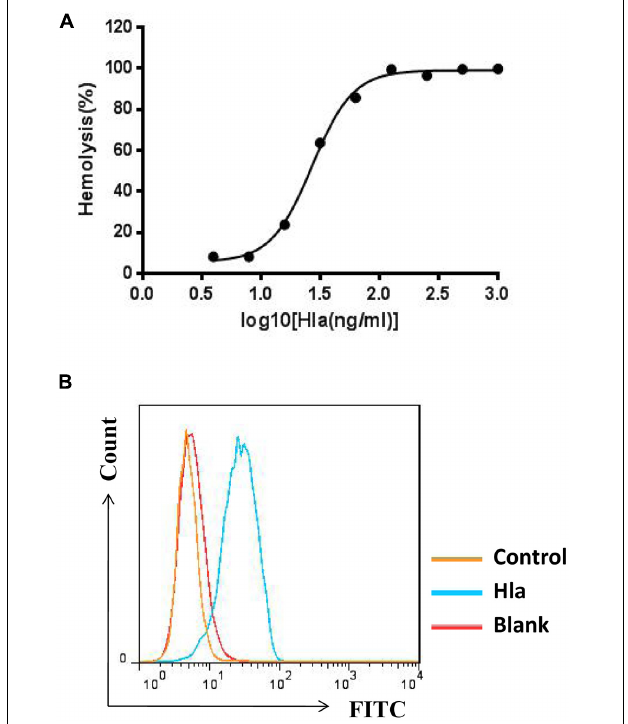
FIGURE 1 | Measurement of Hla activities. (A) Effects of HIa on the lysis of rabbit red blood cells. Serial dilutions of Hla (0, 0.0156, 0.0313, 0.0625, 0.125, 0.25, 0.5, 1, and 2 µ g/mL) were each incubated with rabbit red blood cells for 1 h at 37 ◦ C. The samples were centrifuged, and the absorbance of the supernatants was measured at 405 nm. (B) Hla bound to A549 cells. A549 cells (5 × 10 5 ) were incubated with HIa or control protein (10 µ g/mL)